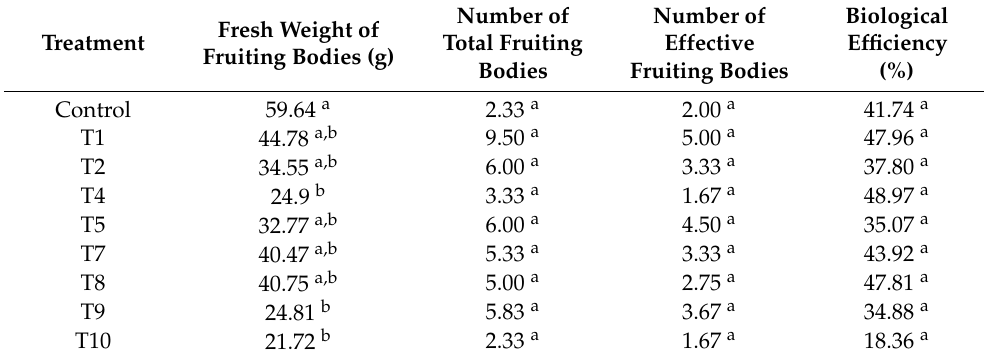
Table 6. Yield of Pleurotus